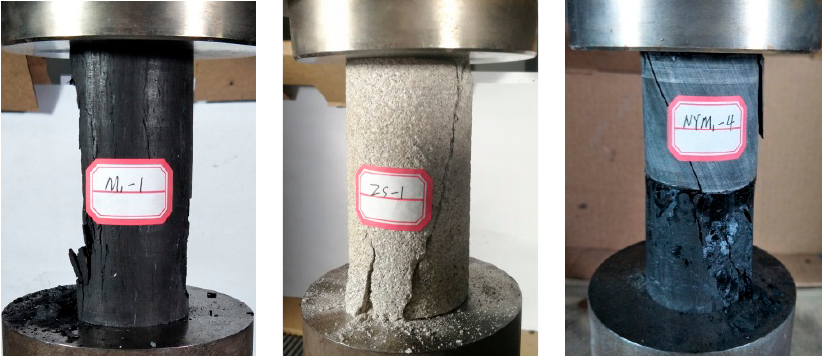
Figure 2. Test process of the specimens.